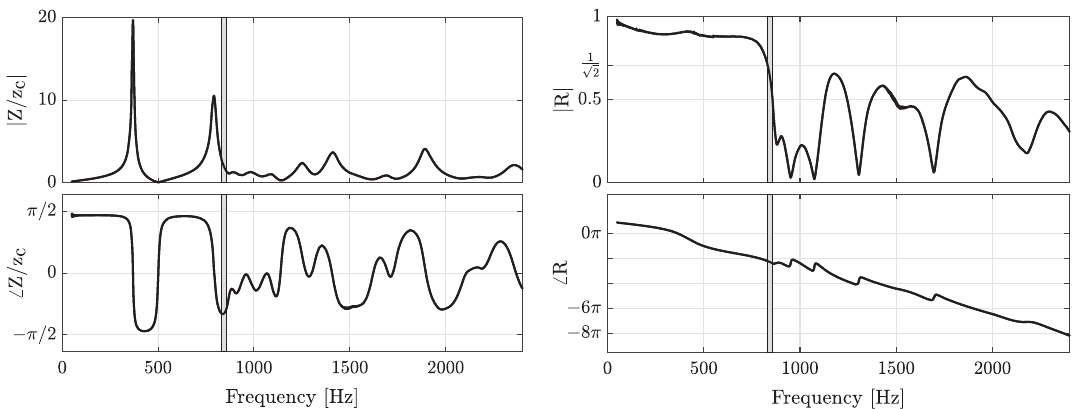
Figure 4. The input impedance (modulus and argument) and re fl ection coef fi cient (modulus and argument), measured for the high C fi ngering (written pitch, 311 Hz) of an alto saxophone. The cutoff transition band f R